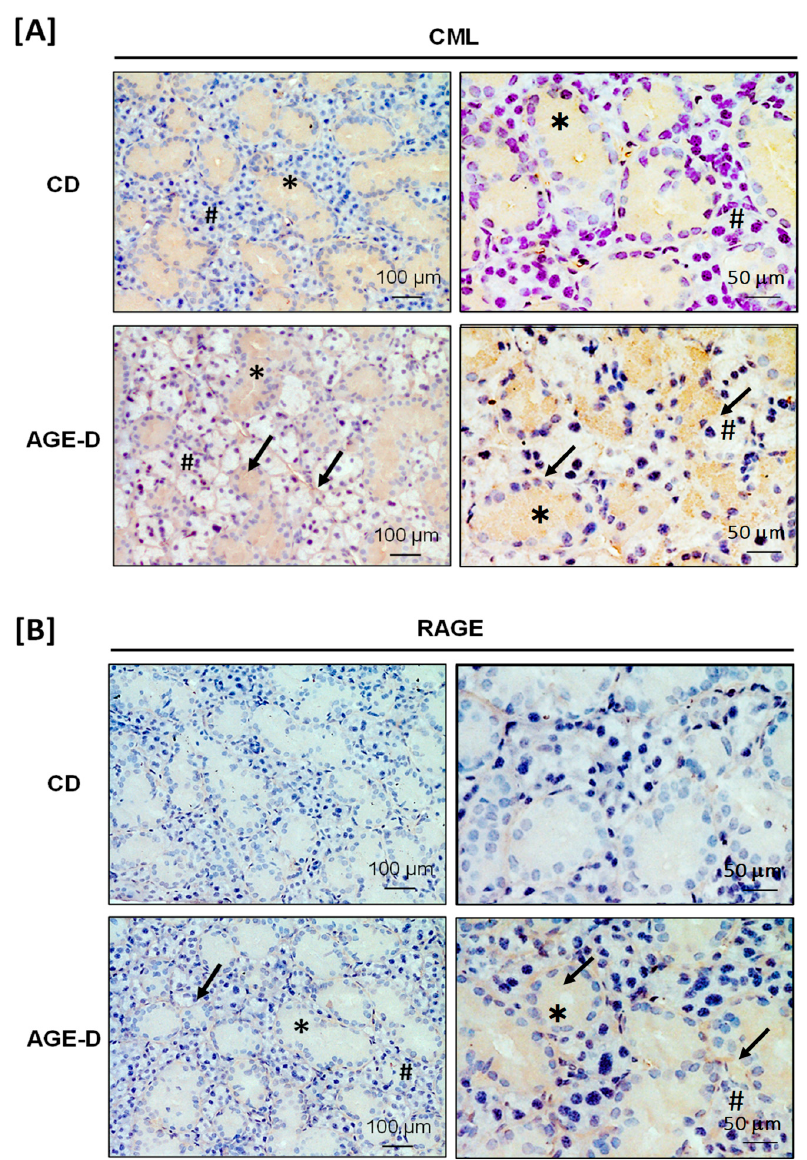
Figure 2. Immunohistochemistry performed on paraffin-embedded submandibular salivary glands.